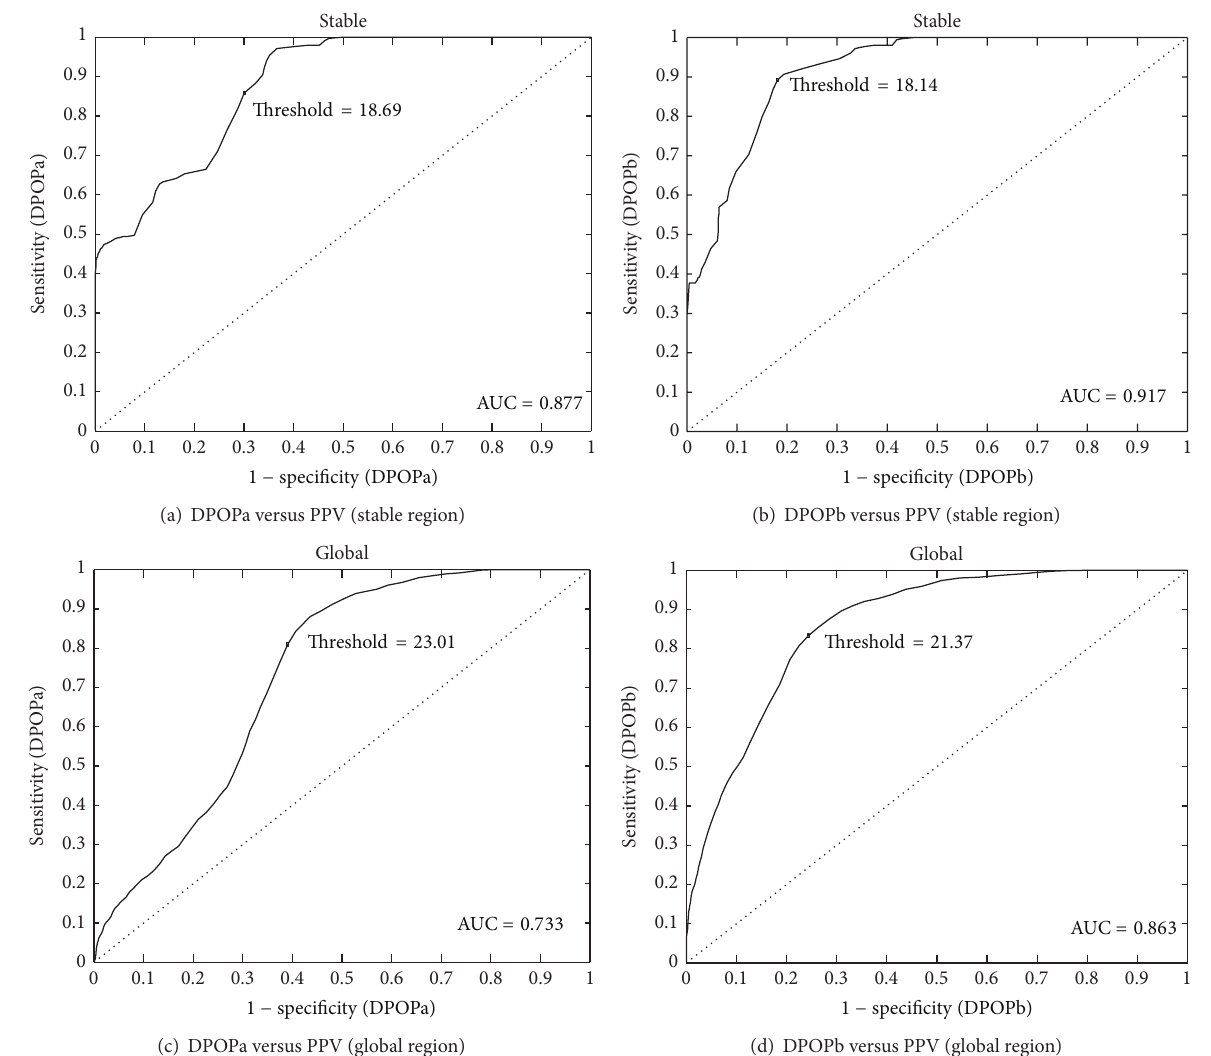
Figure 5: ROC curves corresponding to the data in Figures 3 and